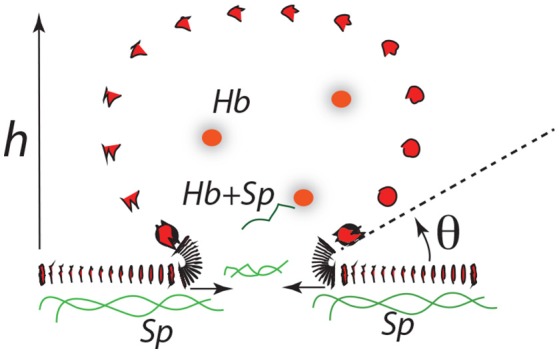
A budding vesicle of height h formed off an initial skeletal/membrane separation of radius ℓ0. The angle θ is the inclination of the vesicle membrane as it just leaves off the cell's membrane body. Note that as θ is reduced the curvature at that location increases dramatically.